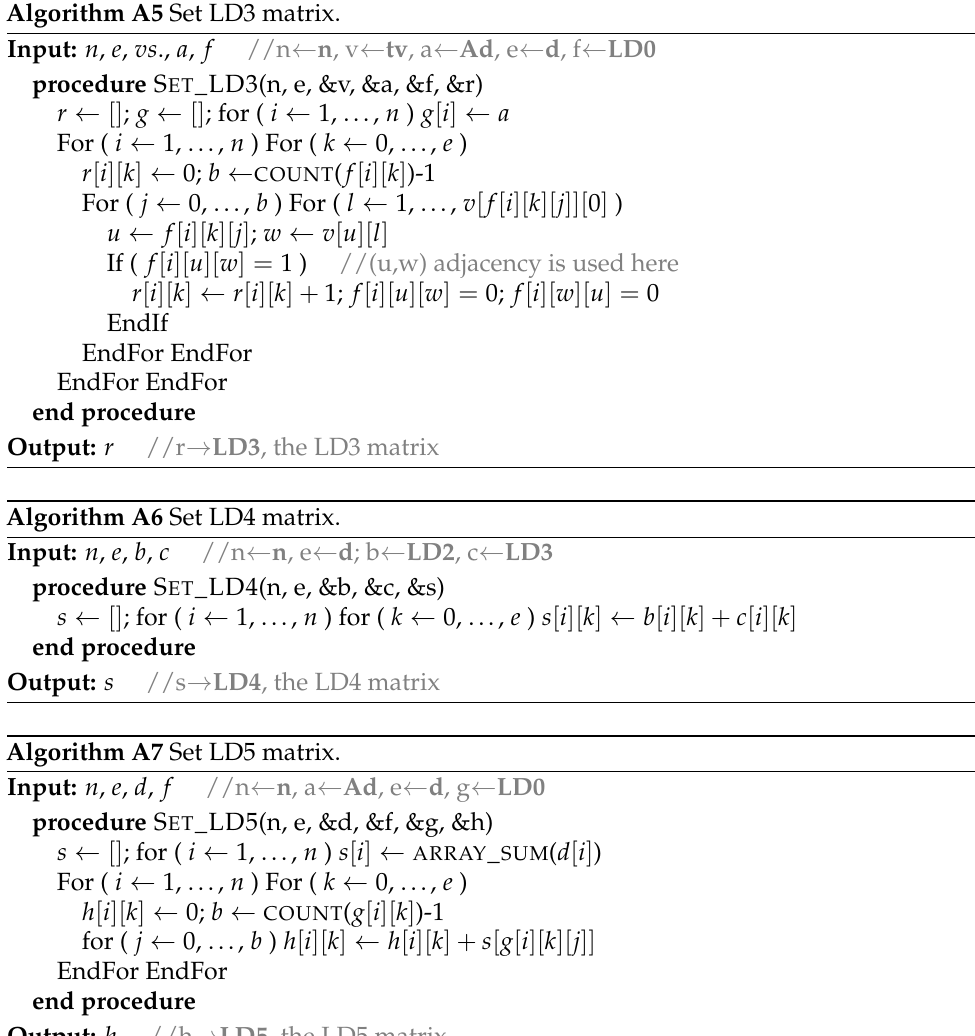
Algorithm A5 Set LD3 matrix.